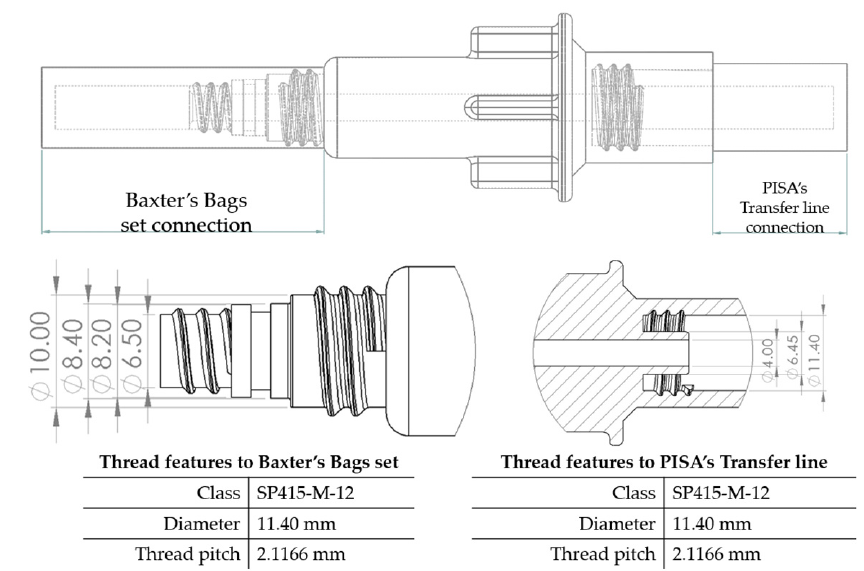
Figure 6. BP connector, join points, and thread features.